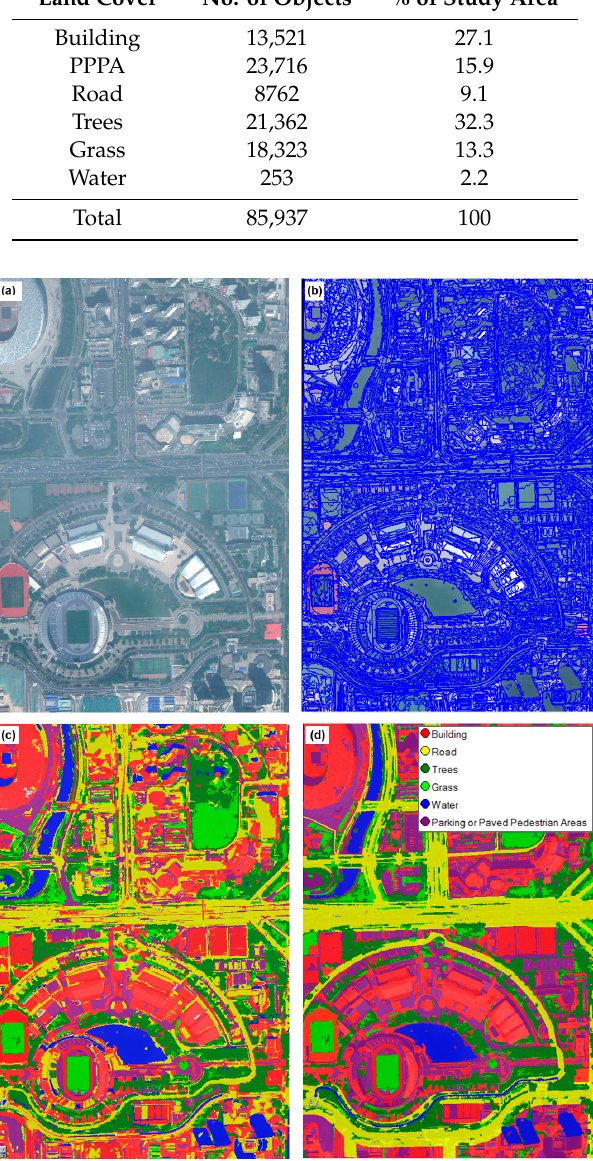
Figure 4. Magnification of an example area (140 ha) within the Olympic Park shown as: WorldView-3 Pansharpened Image (0.4 m) ( a ) Segmented Image ( b ) Bayes Classified Image ( c ), and Bayes Classified Image (after refining rules) ( d ).